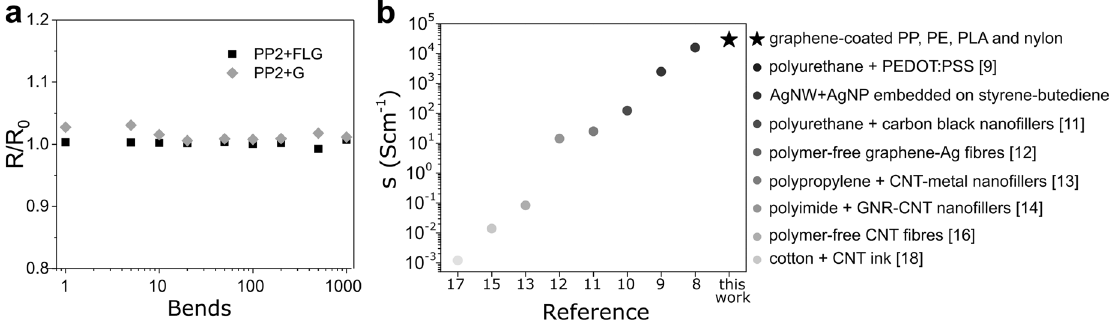
Figure 5. ( a ) Change in resistance upon 1000 bending cycles with bending radius of 5 mm for PP2 + G (grey diamonds) and PP2 + FLG (black squares). ( b ) Comparison between the conductivity of textile fibres presented in this work and in the literature, taking into account the thickness of the conductive